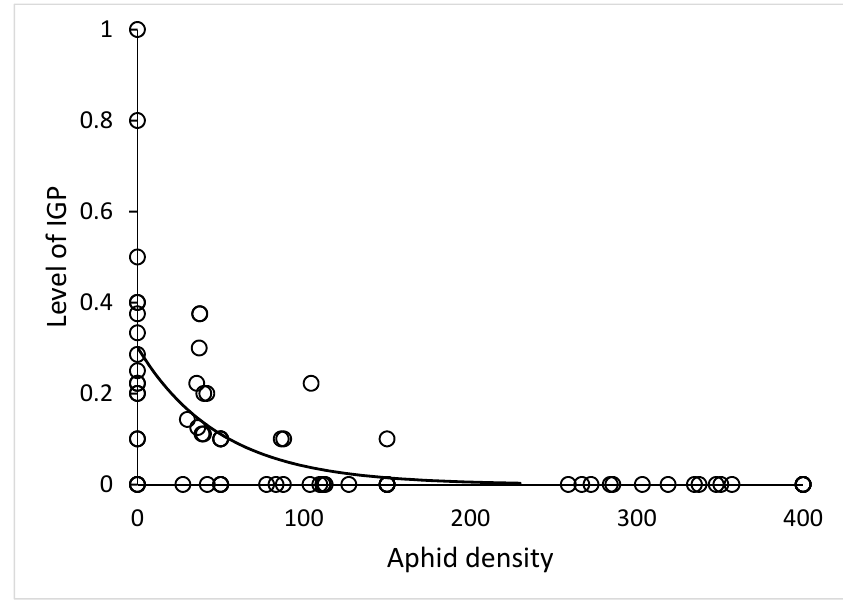
Figure 2. Decrease of the intraguild predation level with increasing density of EGP in a microcosm: y = 0.30*exp(–0.020*x), N = 72.